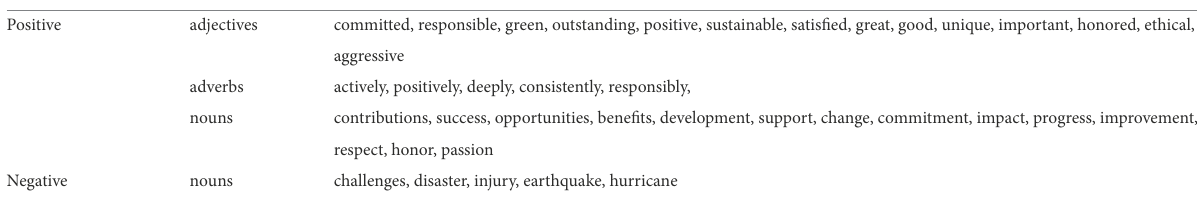
TABLE 3 Collocates of ‘Starbucks’ with explicit evaluative meanings. Grammatical Semantic prosody